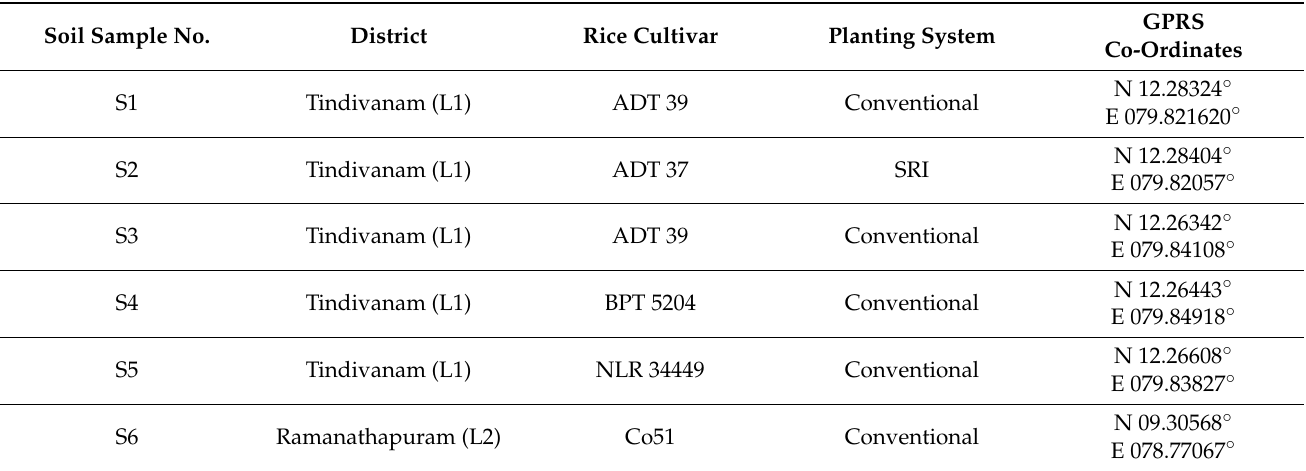
Table 1. Collection of soil samples from rice fields of salt-affected areas from three different districts of Tamil